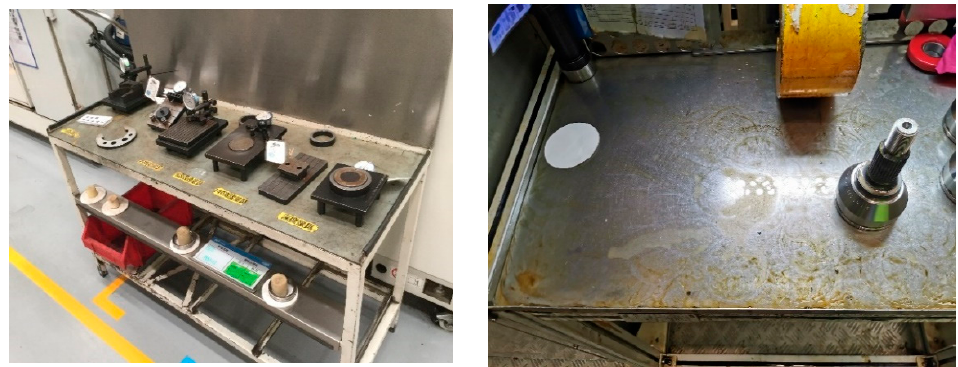
Figure 1. Distribution of oil contamination on workbench surfaces in the SDS workshop.